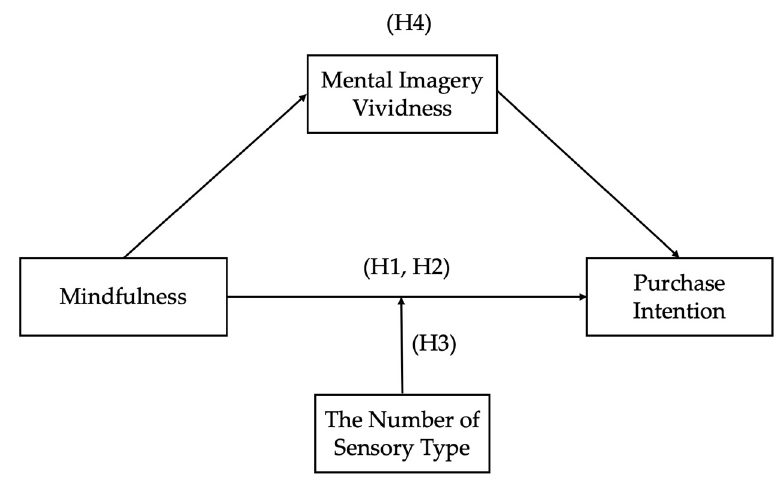
Figure 1. A conceptual model of the hypotheses.